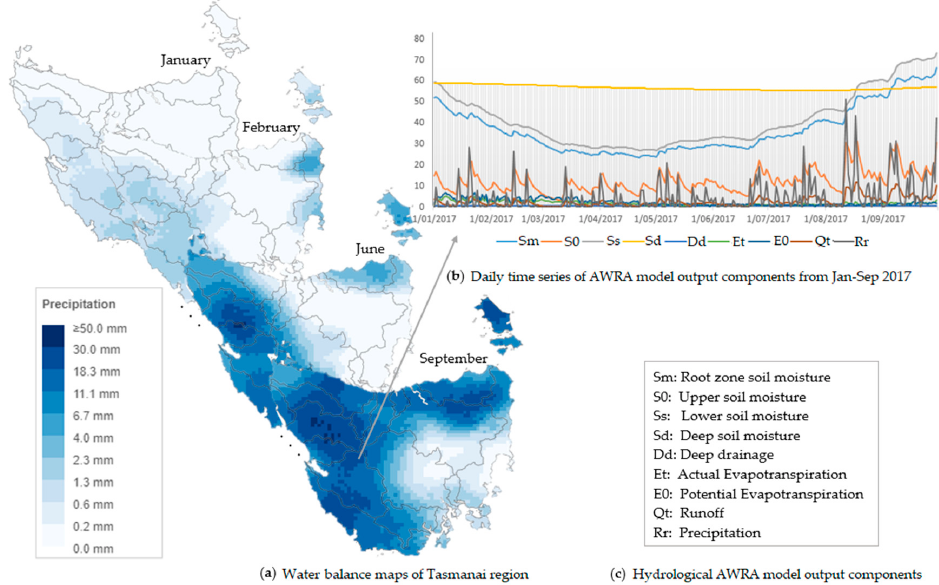
Figure 1. ( a ) Water balance map of Tasmania region for Australian Water Resource Assessment (AWRA) model output from January–September 2017, ( b ) each pixel shows daily time series of nine hydrological AWRA components from January–September 2017 and ( c ) hydrological components of AWRA model output.